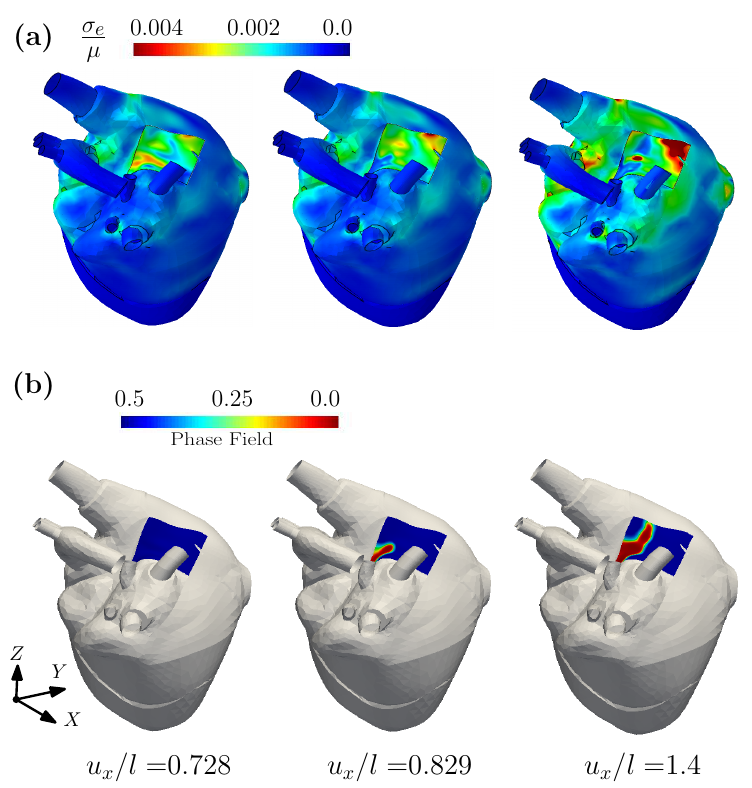
Figure 5. ( a ) The contour plots of normalized effective Cauchy stress and ( b ) the contour plots of phase field for a heart model and a biosensor shell, under different